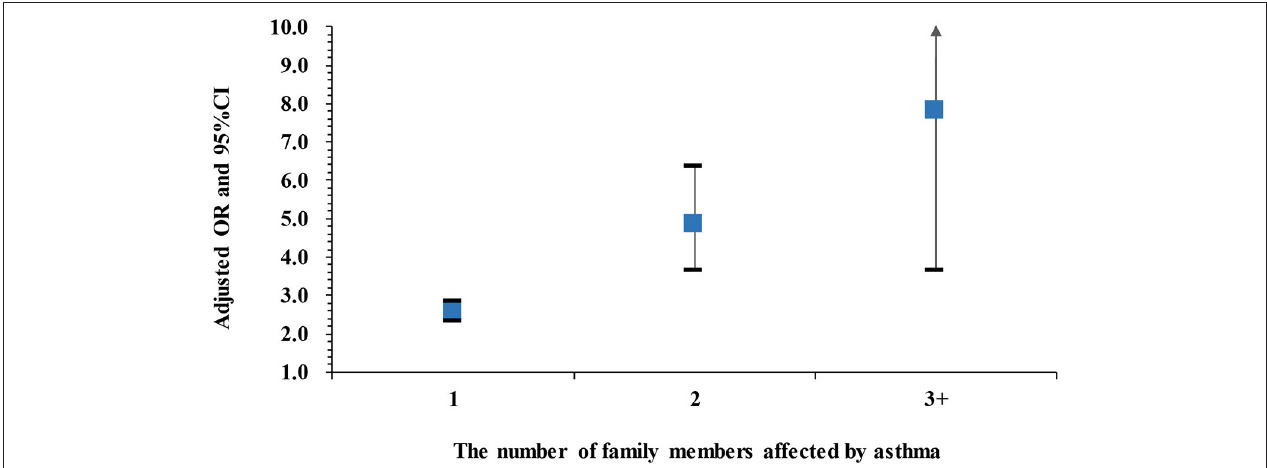
FIGURE 1 | Adjusted ORs and 95%CIs for childhood asthma by the number of family members affected by asthma compared to those without any family member affected. Adjusted for passive smoke exposure, home coal use, pet kept and PM 2.5 exposure. Asthma cases: 3,529 cases with 1 family member affected, 279 cases with 2 family members affected, and 35 cases with ≥ 3 family members affected.